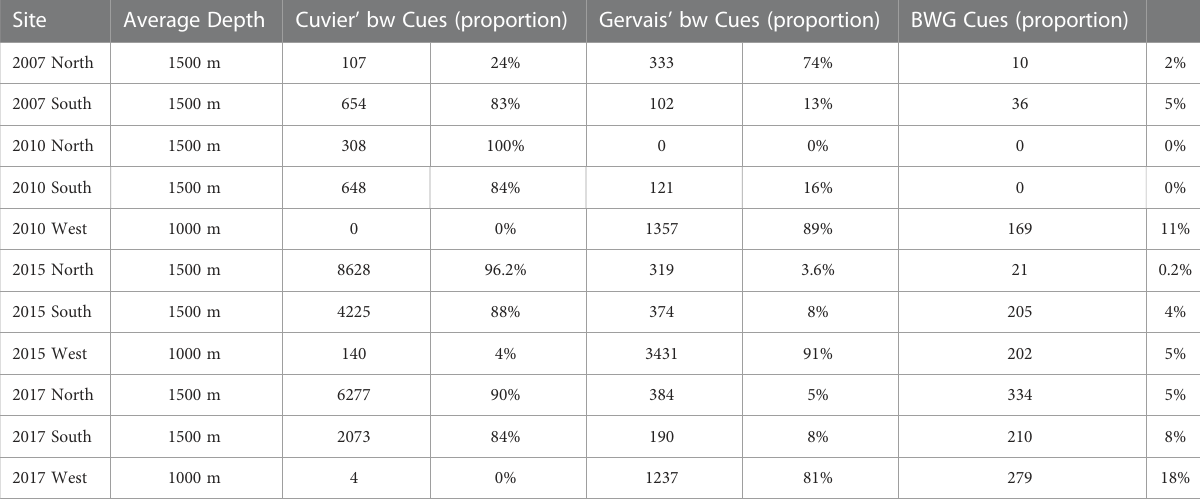
TABLE 4 Number and proportion (in %) of detected cues per species per